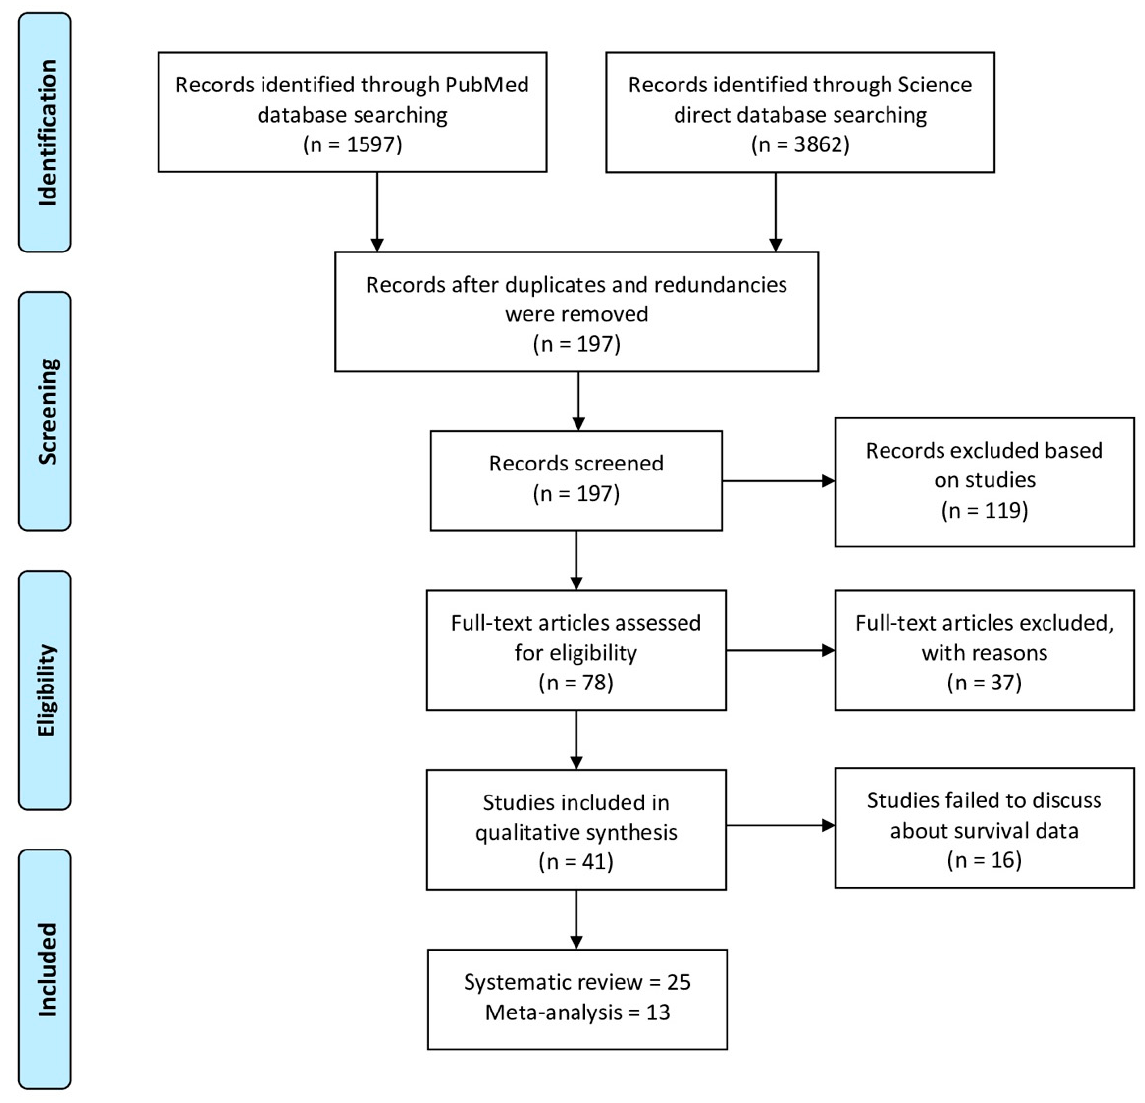
Figure 1. Schematic representation of selection of articles for this meta-analysis and a comprehensive review.